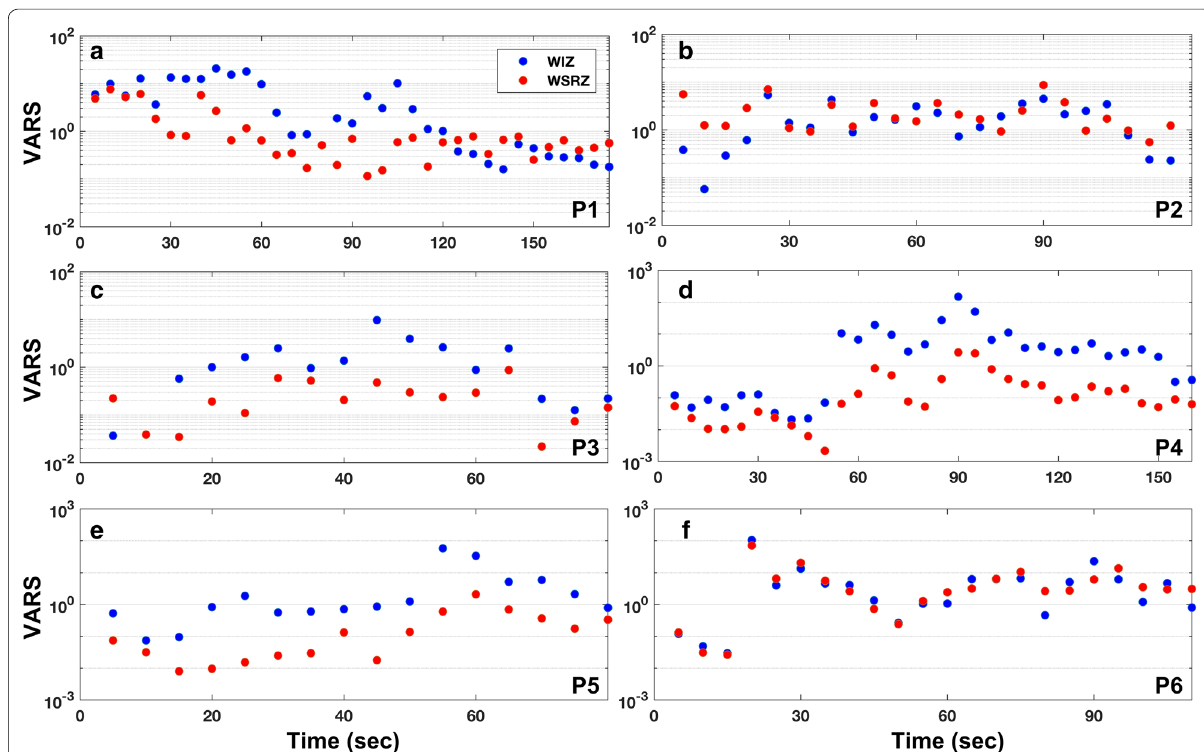
Fig. 12 VASR plots for each of the eruptive pulses with time during the 27 April 2016 eruption. a Pulse 1, b pulse 2, c pulse 3, d pulse 4, e pulse 5, f pulse 6. Blue circles are VASRs for station WIZ, and red circles are VASRs for station WSRZ. 5-s time windows were used to estimate the VASR through